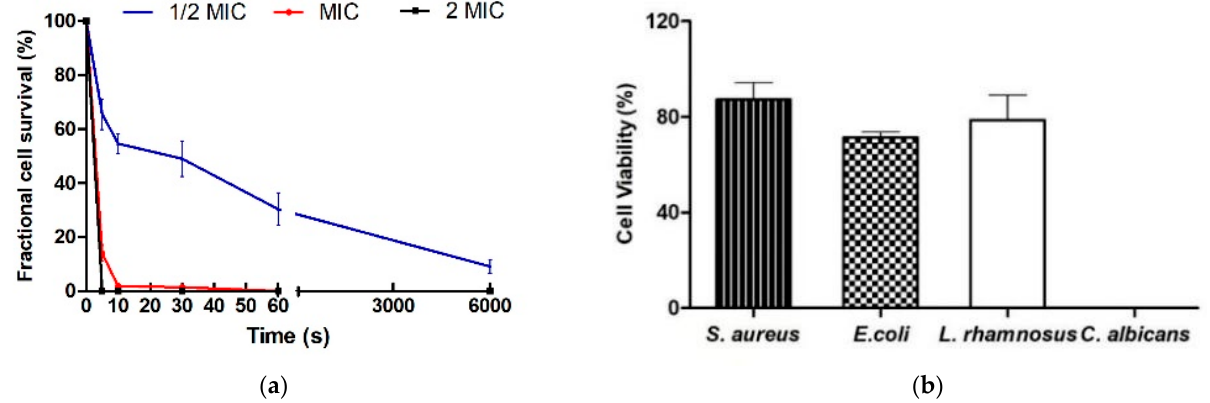
Figure 4. Time killing curve and fractional cell survival treated with potential peptide ( a ); The fractional cell survival of bacteria and fungi treated with potential peptide ( b ).